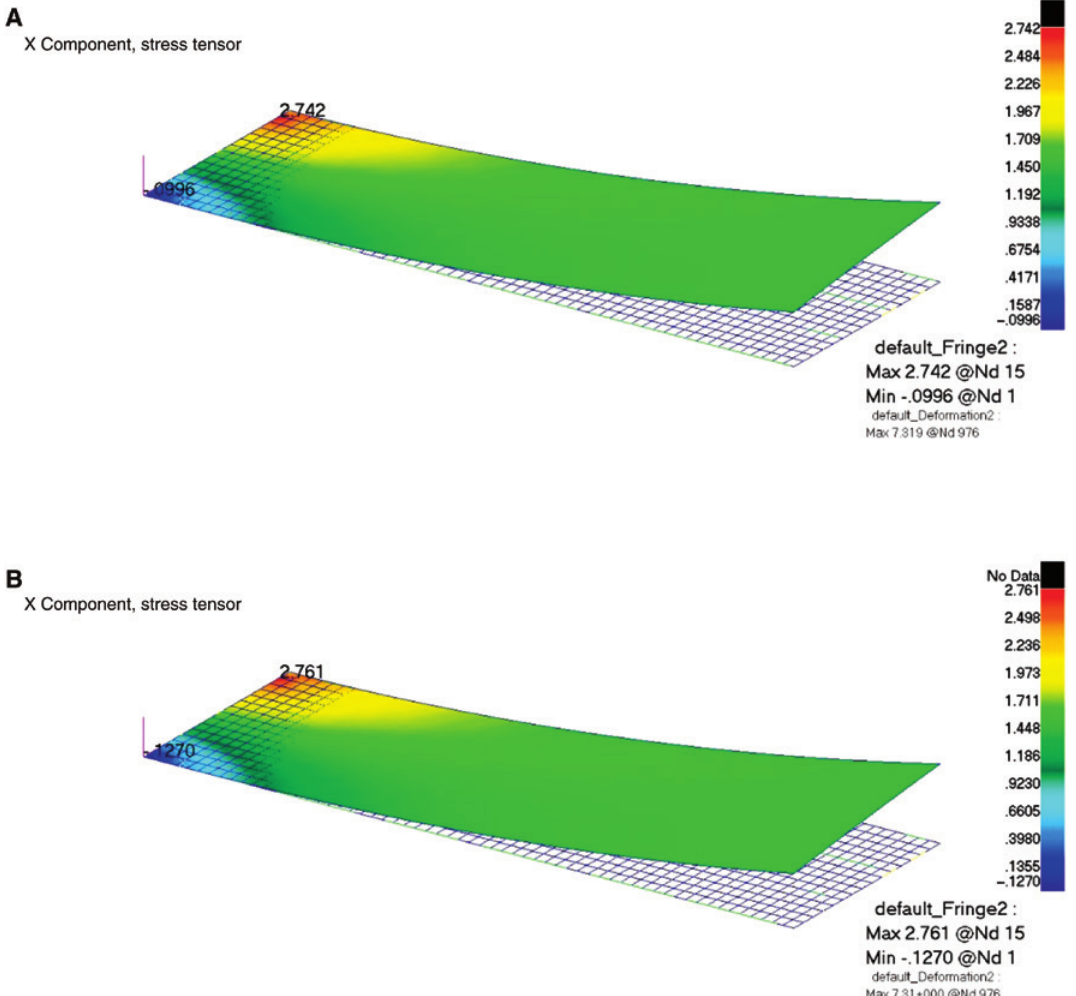
= 1 N, deformed shape and stress contours, σ y